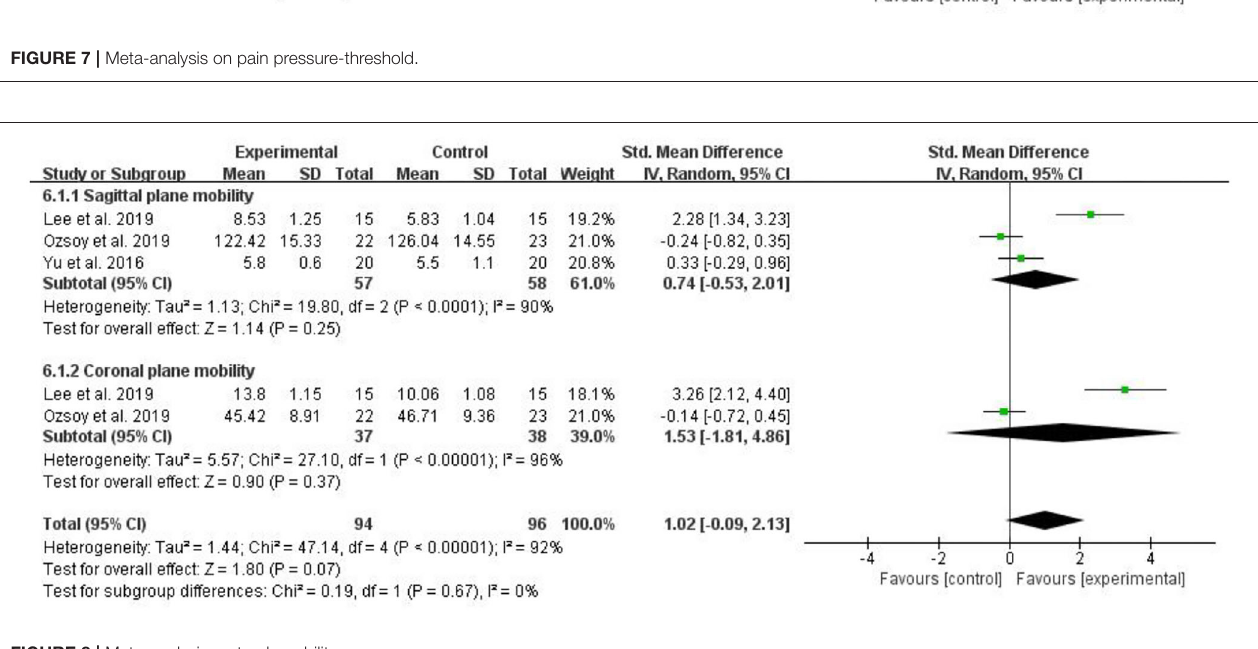
FIGURE 8 | Meta-analysis on trunk mobility.